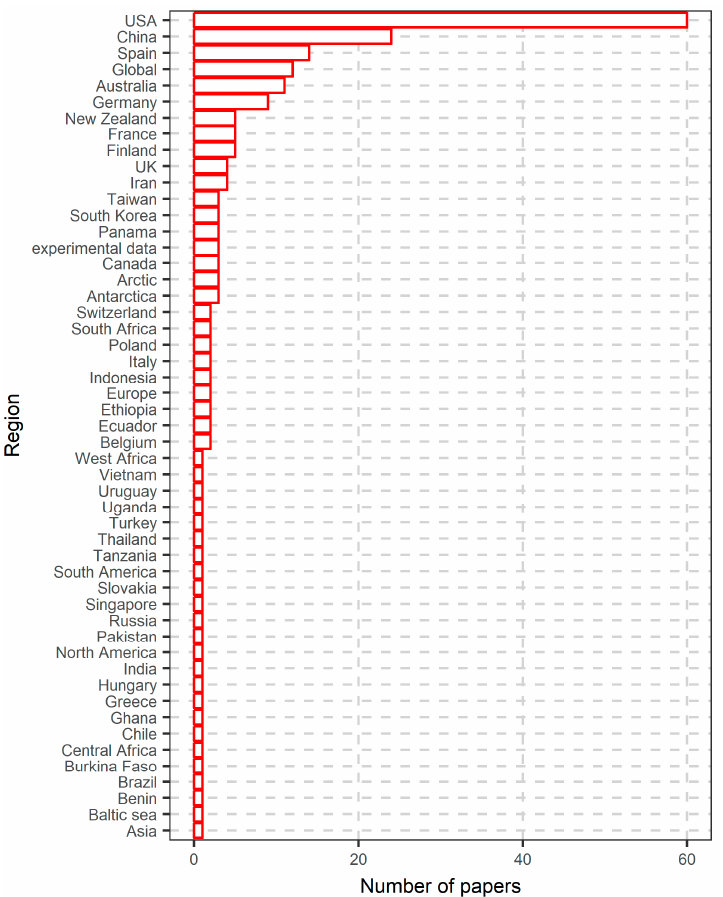
Figure 5. Number of published RF-related papers conditioned on region of application.